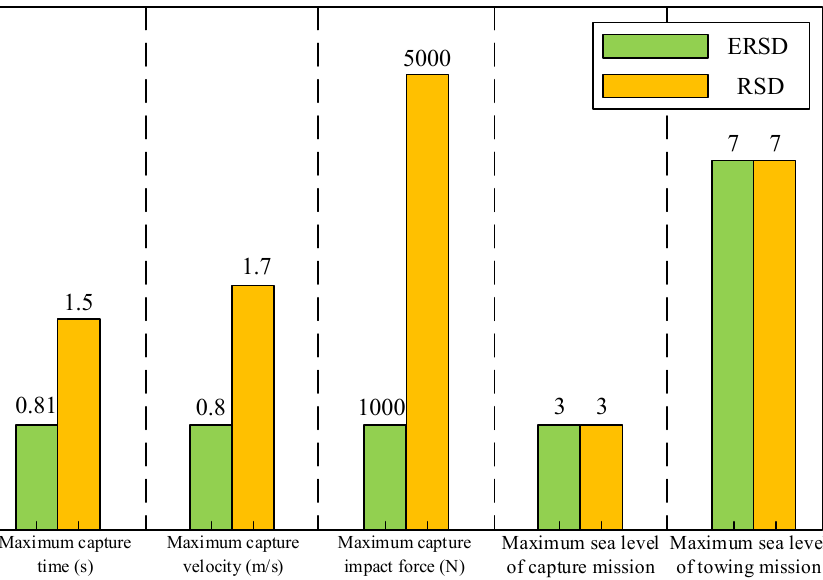
Figure 15. Comparison of operating parameters between RSD and ERSD.